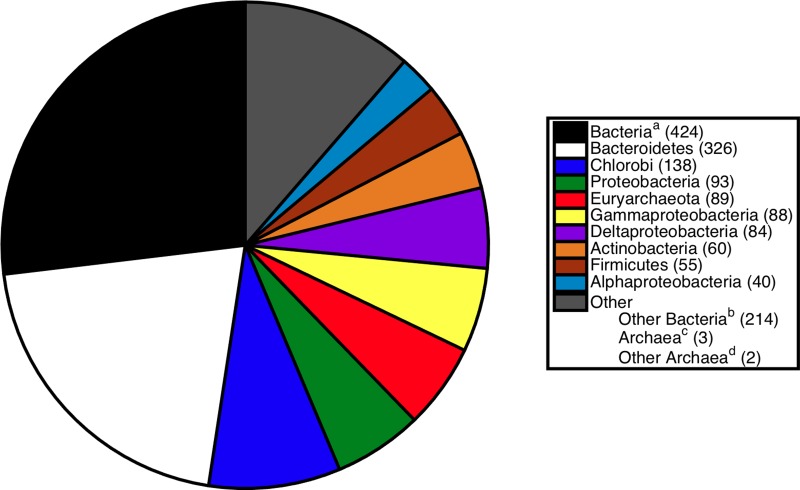
Breakdown of sister relationships to the subtree for S. ruber in 2,315 gene trees generated for strain M8.aBacteria, the sister subtree contained more than one bacterial phyla. bOther Bacteria, the sister consisted of a single bacterial phyla not already listed above. cArchaea, the sister subtree contained more than one archaeal phyla. dOther Archaea, the sister consisted of a single archaeal phyla other than Euryarchaeota.